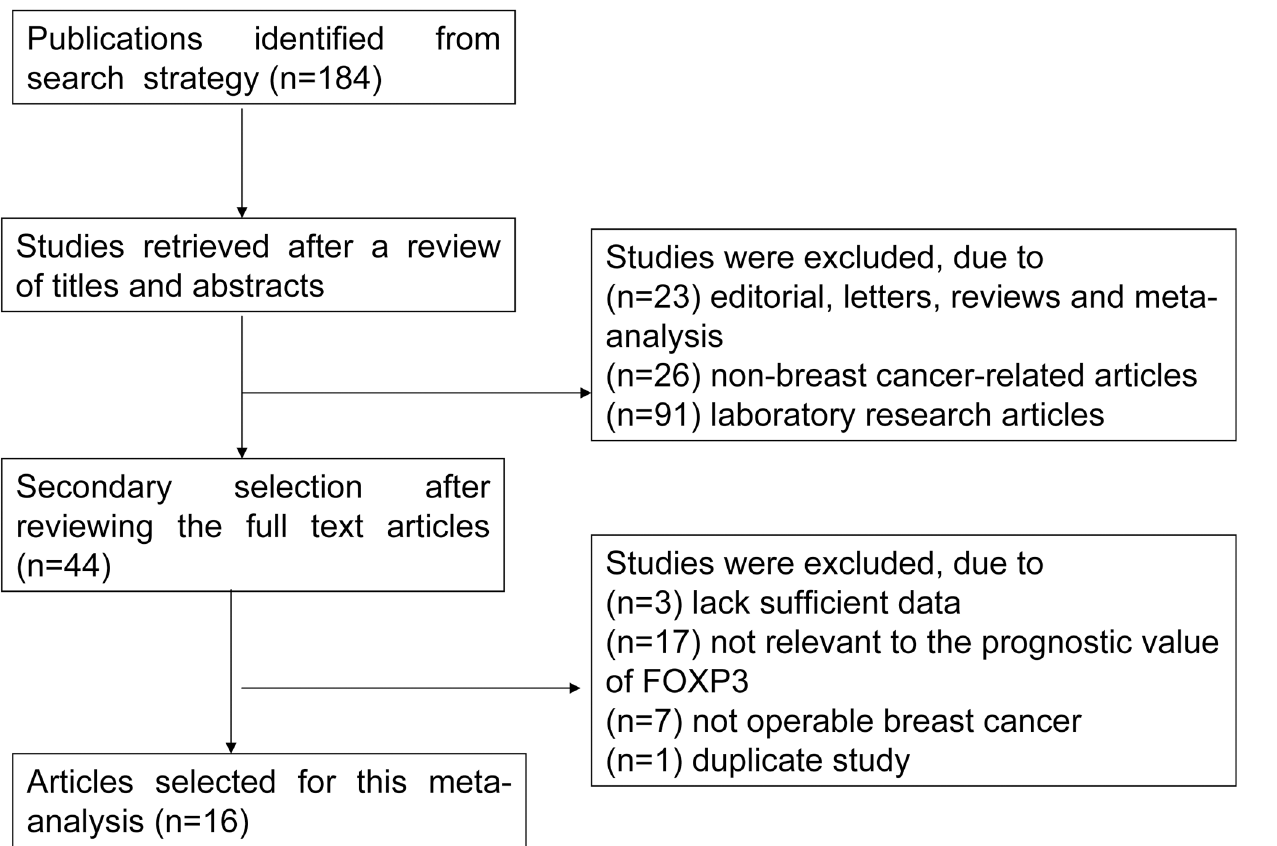
Fig 1. Meta-analysis flow